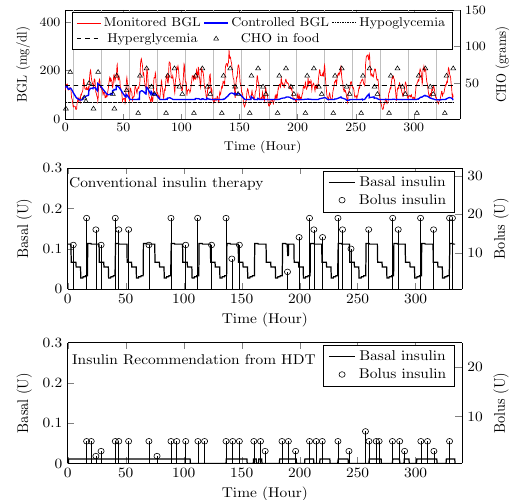
Figure 25. Insulin recommendation and BGL for P 2 —Comparison between uncontrolled clinical trial and controlled BGL excursions with HDT framework is shown in the top plot. The middle plot shows the insulin recommendation during the clinical trial, and the bottom plot shows the insulin recommendation from HDT.